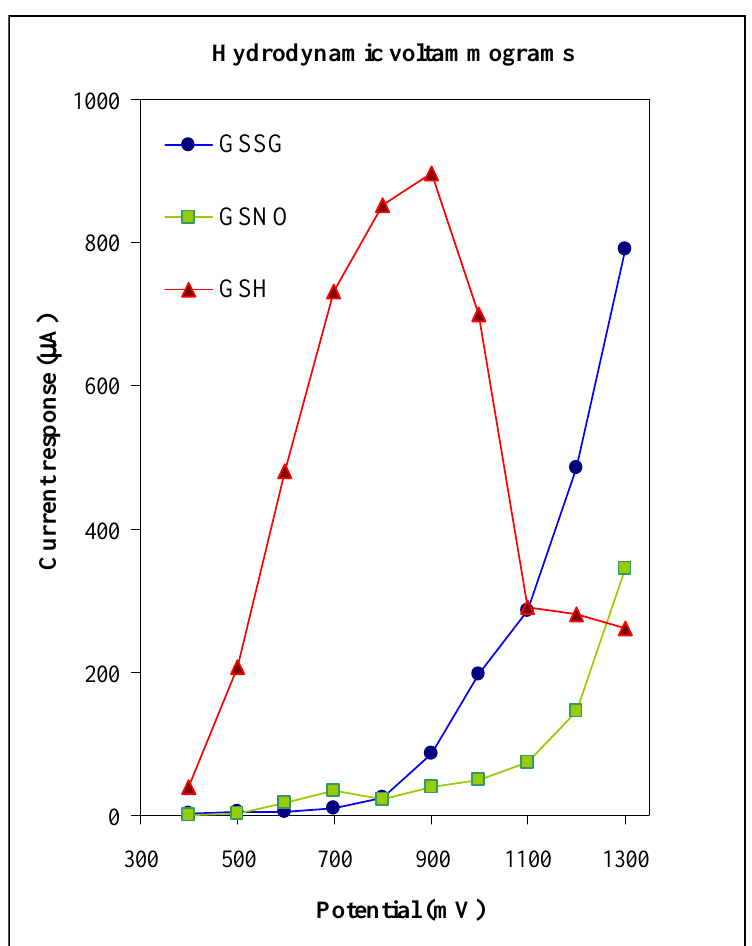
Figure 3. Hydrodynamic voltammograms of GSH, GSSG and GSNO measured on glassy carbon electrode. Mobile phase: 0.2 M acetate buffer. For other details see Fig.